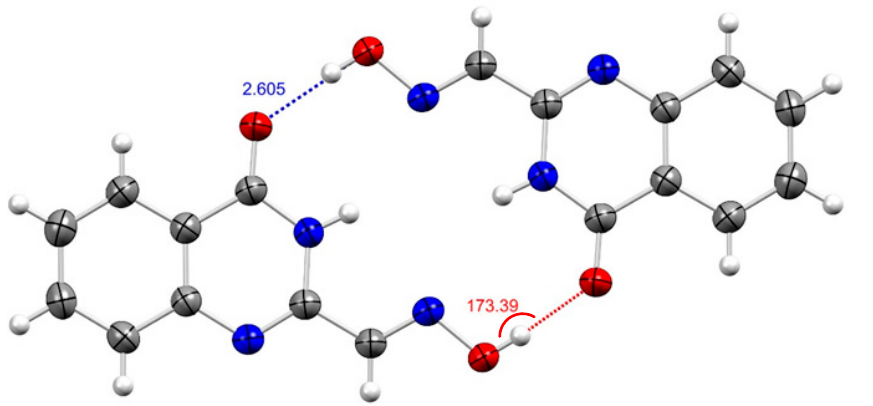
Figure 3. ORTEP view of notable intermolecular interactions (Å, in blue) and related bond angles (°, in red) from the crystal structure of ( E )-4-oxo-3,4-dihydroquinazoline-2-carbaldehyde oxime ( 8 ); thermal ellipsoids at 50% probability.